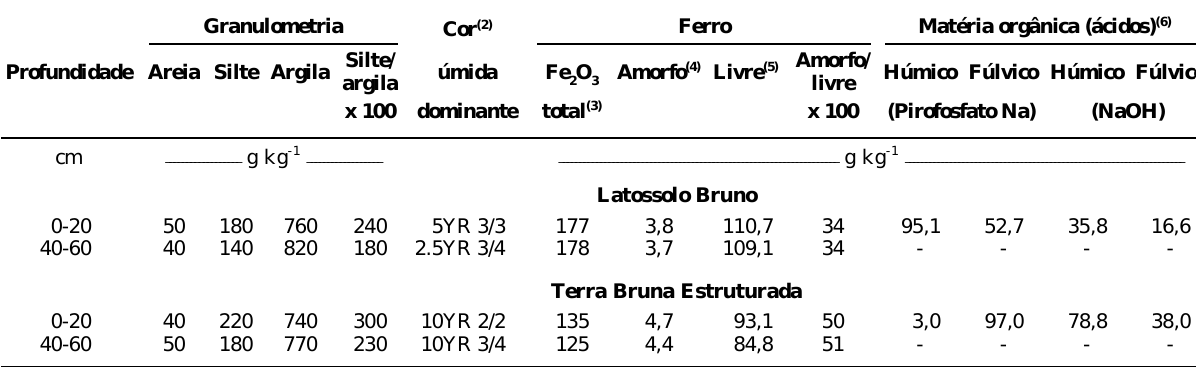
Quadro 1. Resultados médios (1) das análises granulométricas, cor úmida, formas de ferro e matéria orgânica